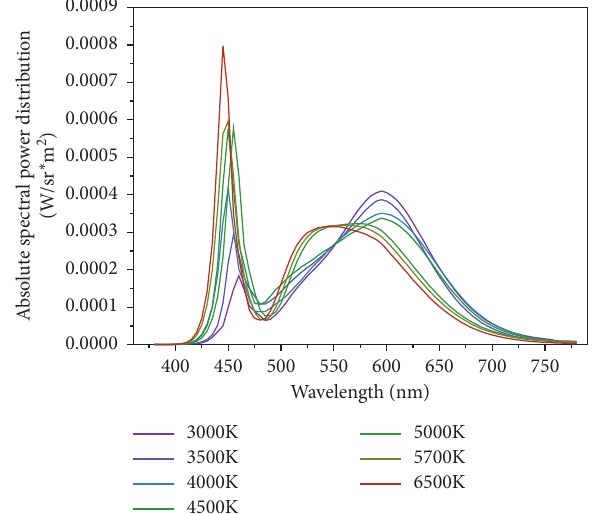
Figure 2: Spectral power distribution of 7 LEDs with different CCTs.